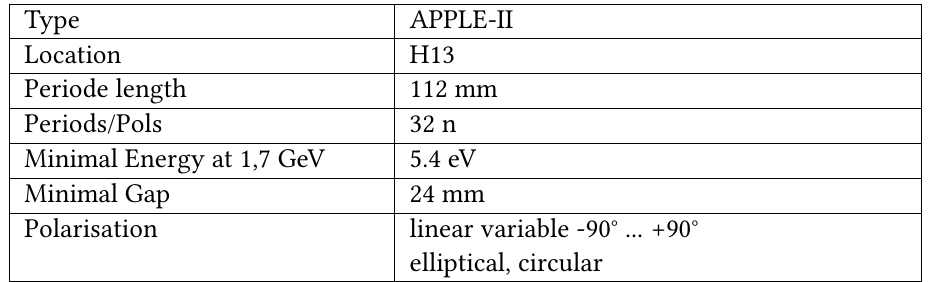
Table 2: Parameters of the insertion device UE112.